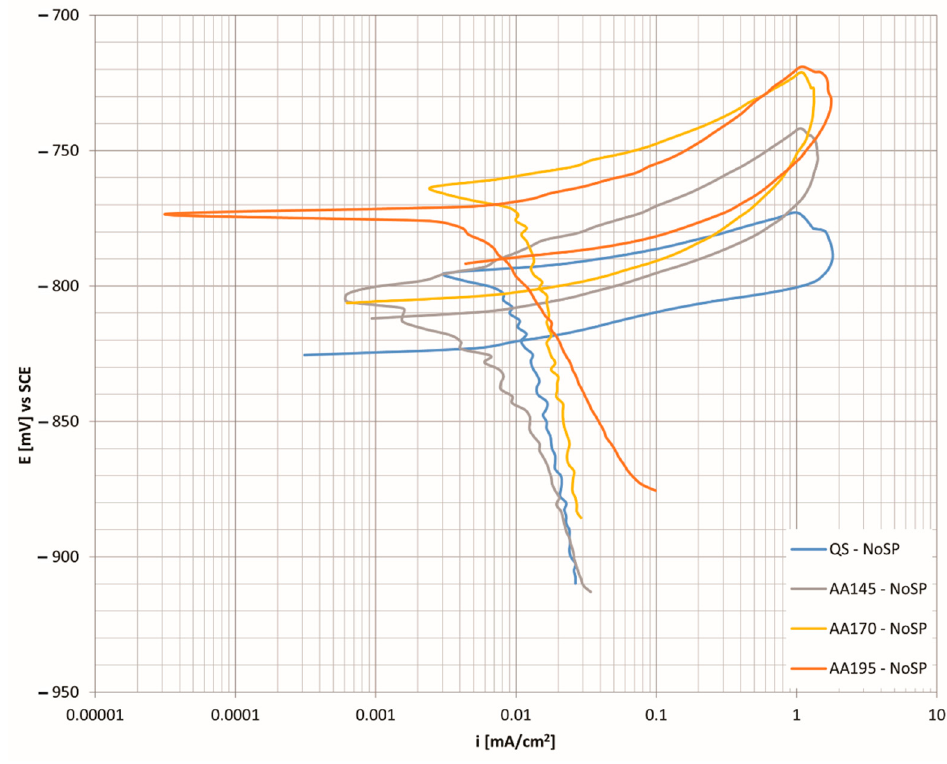
Figure 6. CP curves as a function of the corrosion current density for the unhardened state at differ- ent age hardening temperatures. age hardening